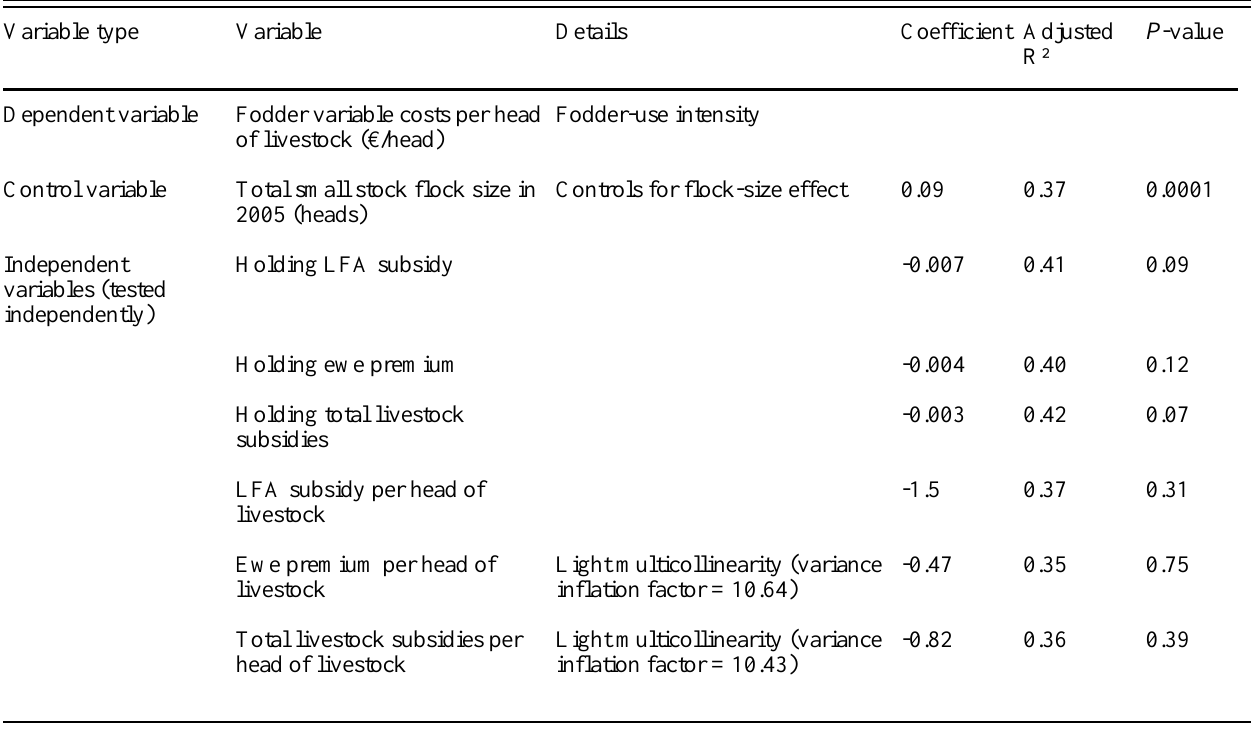
Table 4. Linear regression results for livestock subsidies (per farm and per head of livestock) as explanatory variables for stock-breeding intensification ( n =